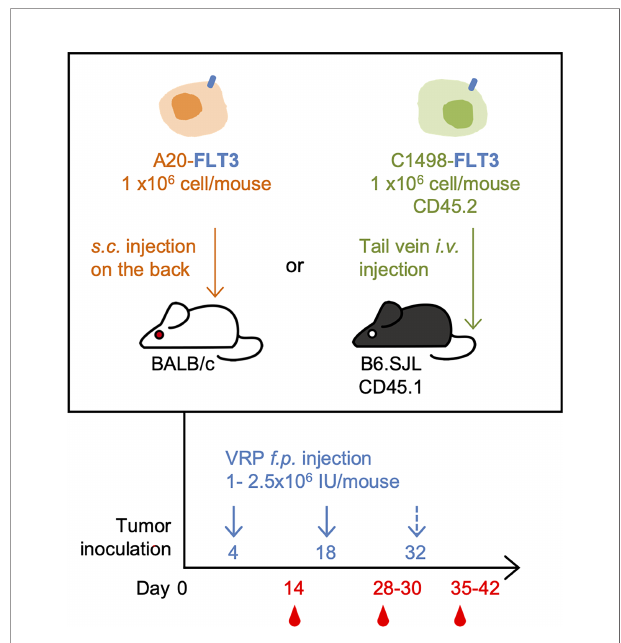
FIGURE 1 | The mouse lymphoma model and leukemia model, and the VRP vaccination strategy. FLT3-expressing A20 tumor cells were inoculated subcutaneously on the back of BALB/c mice on day 0. Tumor-challenged mice were vaccinated on days 4 and 18 with 1 x 10 6 IU of VRP-Ctrl or VRP- FLT3 on the footpad. Control mice received PBS (n= 5 per group). FLT3- expressing C1498 tumor cells were inoculated intravenously through tail vein of B6.SJL mice on day 0. Mice were vaccinated on day 4 and 18, and day 32 in one repeat of this model with 1-2.5 x 10 6 IU of VRP-Ctrl or VRP-FLT3 on the footpad. The control mice received PBS (n= 5 or 10 per group). Blood samples were harvested on day 14, 28, and